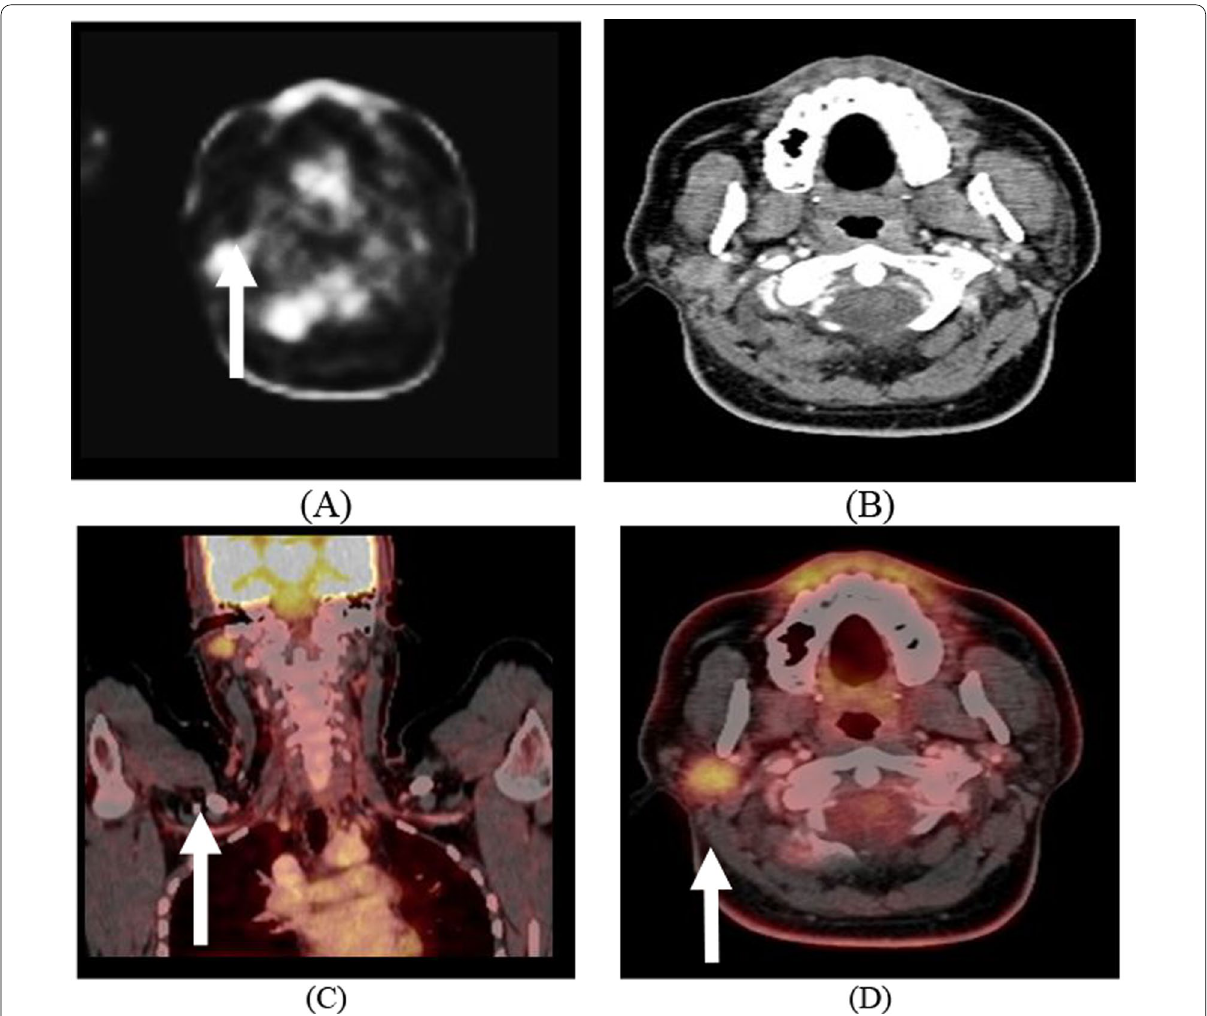
Fig. 2 A twenty seven years old male patient, diagnosed with papillary differentiated cancer thyroid. underwent total thyroidectomy, followed by 120 mCi RAI-131 ablation. Follow up negative iodine whole body scan done 1 year later, inspite of elevated thyroglobulin level ( was done and showed right retro-mandibular/pre-auricular soft tissue nodule (nodal) with SUVmax ~ 7.2. Axial PET only ( a ), CT ( b ) Axial & Coronal fused PETCT images ( c , d ) showed right retromandibular/retro-auricular soft tissue lesion/Lymph node (Arrows)